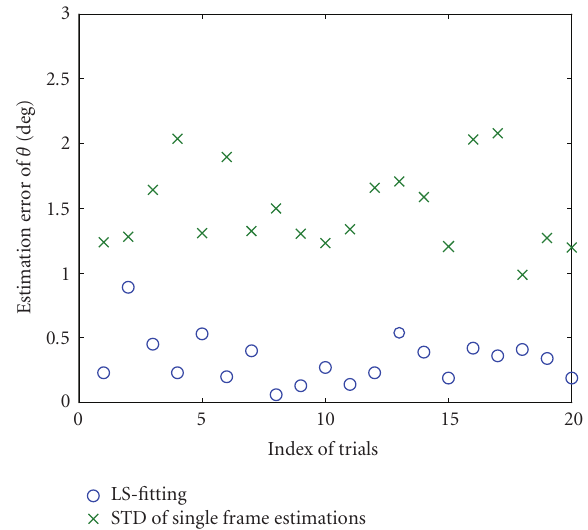
Figure 13: Comparison of the DOA estimation error (20